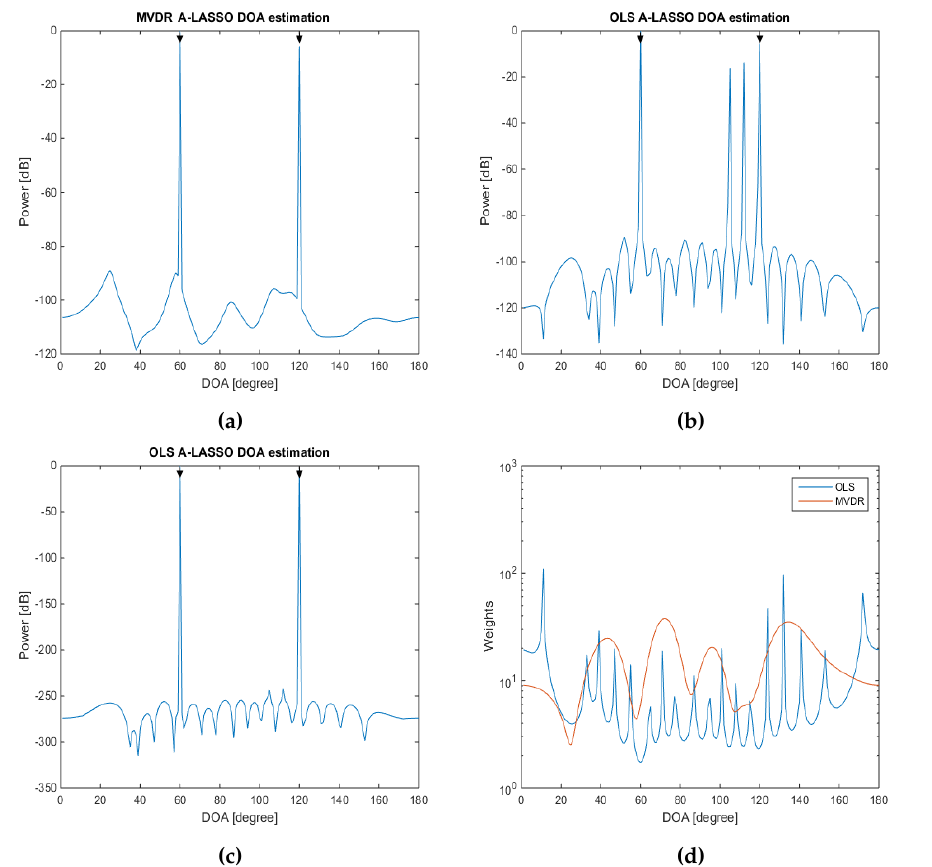
Figure 11. DOA estimation using A-LASSO algorithms, for two source signals at DOAs 60 ◦ and 120 ◦ , 10 snapshots, SNR = 0 dB. ( a ) MVDR A-LASSO after the first iteration; ( b ) OLS A-LASSO after the first iteration; ( c ) OLS A-LASSO after five iterations; and ( d ) initial weights of the two algorithms.